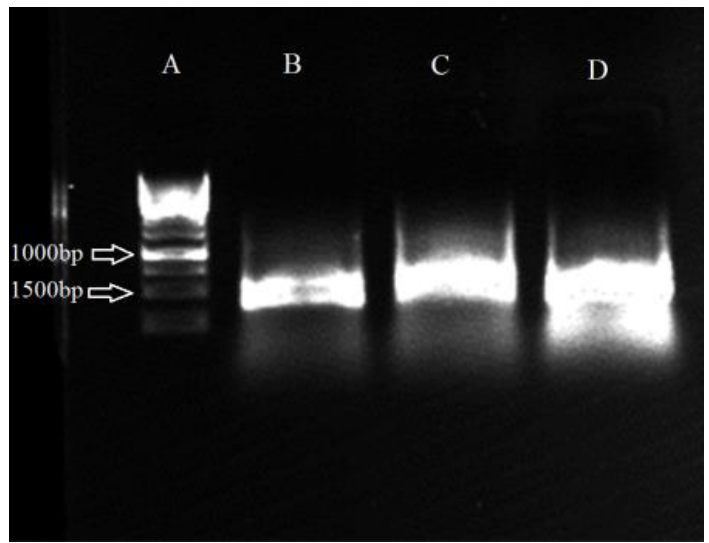
Figure 9. Molecular identification of Streptomycete isolates: ( A ) Ladder, amplification of 16S rDNA of Streptomyces sp. Isolates by PCR: ( B ) isolate G, ( C ) isolate No. 5, and ( D ) isolate U.